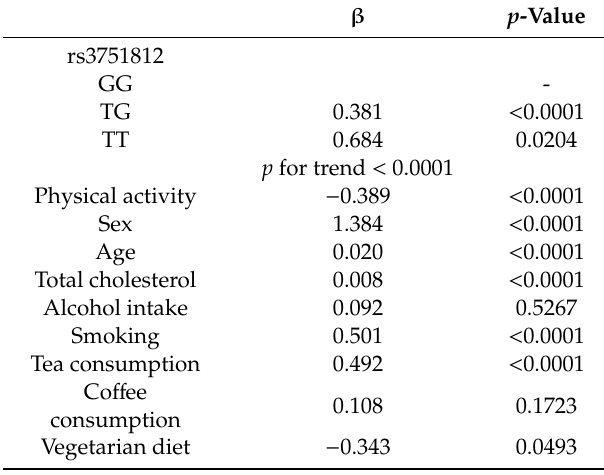
Table 3. Linear regression analysis showing the association between rs3751812 and BMI.